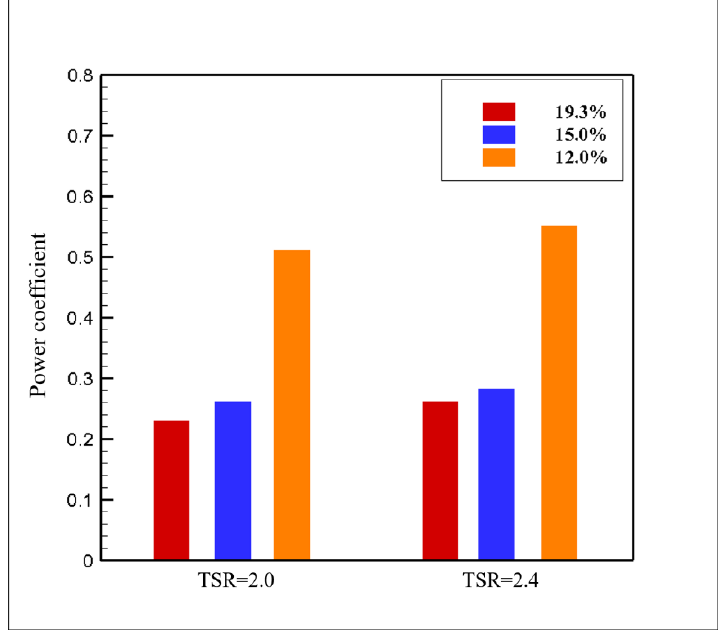
Figure 16. Power coefficient of the turbine with respect to tip clearance.